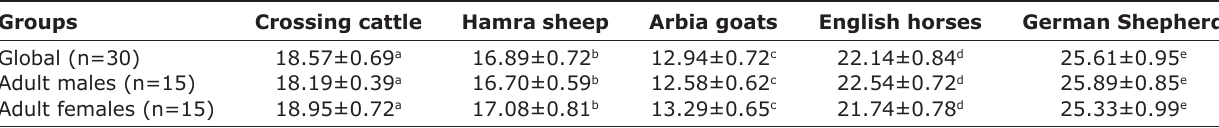
Table-5: Influence of red blood cells circumference on the species determination of pets (Group 2, expressed in μ m). Groups